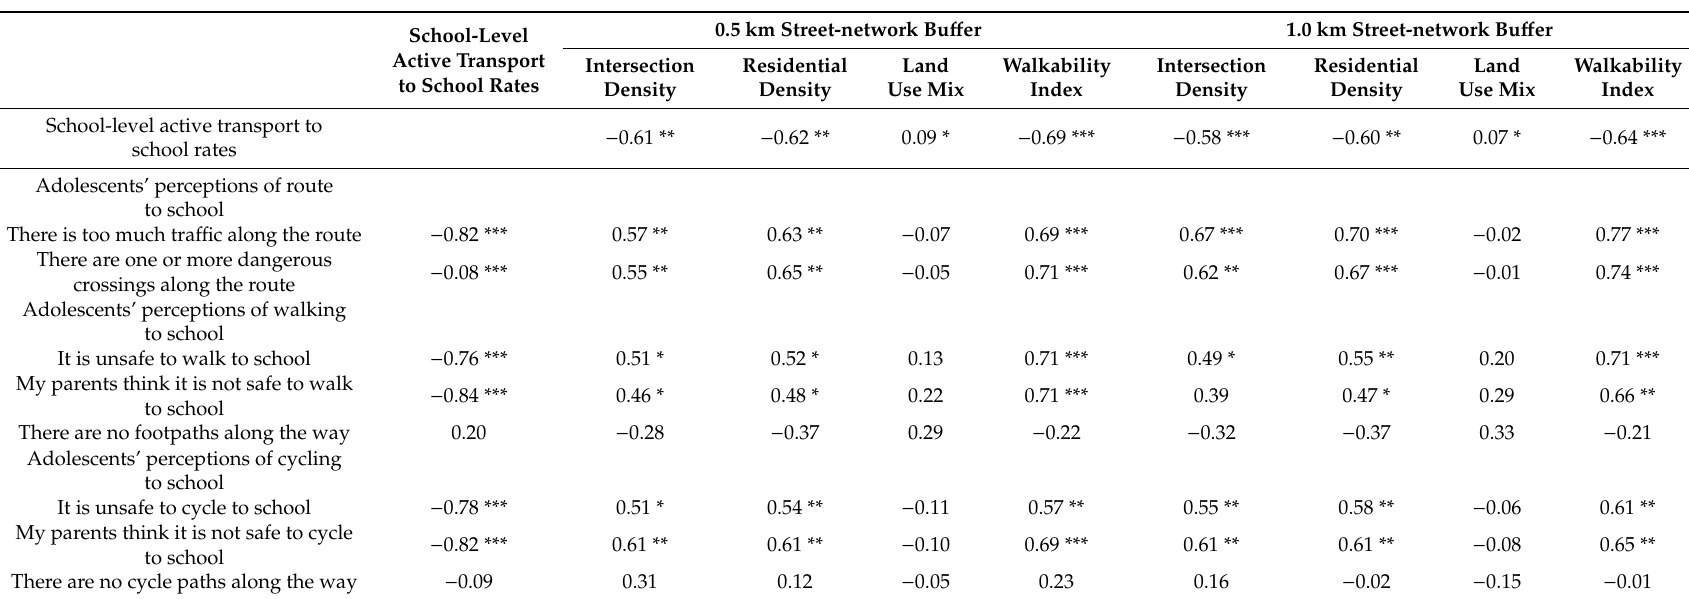
Table 4. Correlations between school-level rates of active transport to school, objectively measured BE features, and adolescents’ perceptions of school